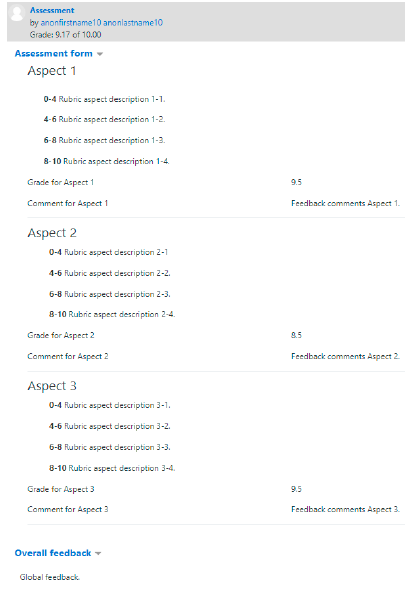
Figure 2. Detail of a submission review in Moodle Workshop.